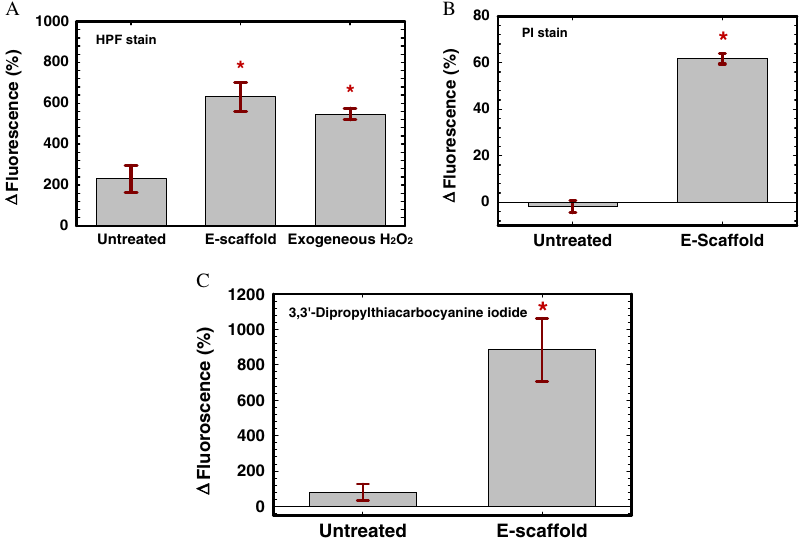
Fig. 3 E-scaffold increases OH • formation and membrane permeability. a Increase in fl uorescence of HPF-stained e-scaffold treated and exogenous